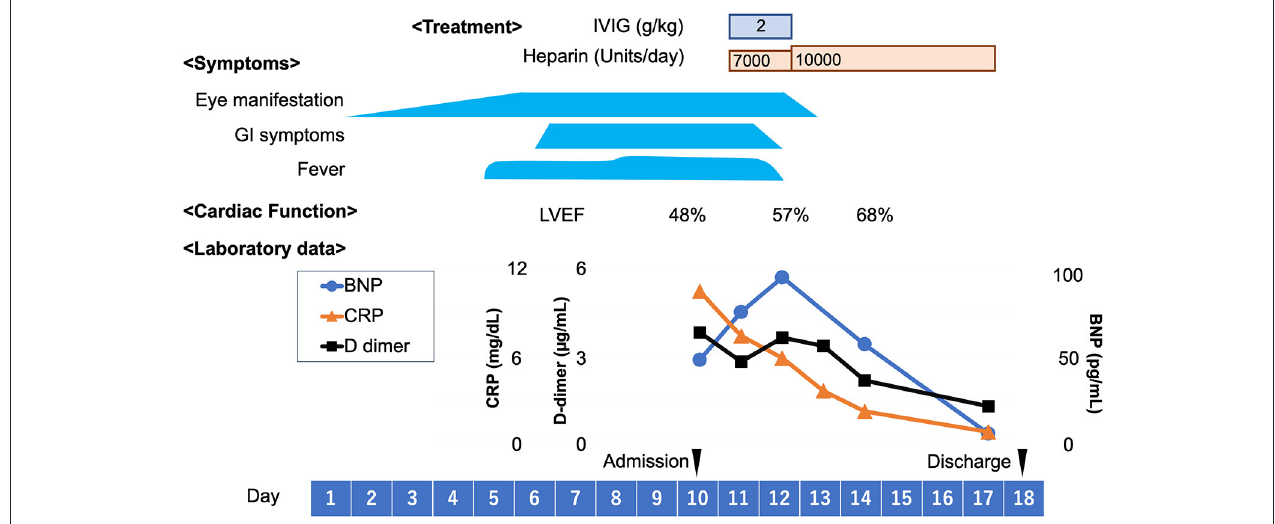
FIGURE 3 | Clinical course. BNP, brain natriuretic peptide; CRP, C-reactive protein; GI, gastrointestinal; IVIG, intravenous immunoglobulin; LVEF, left ventricular ejection